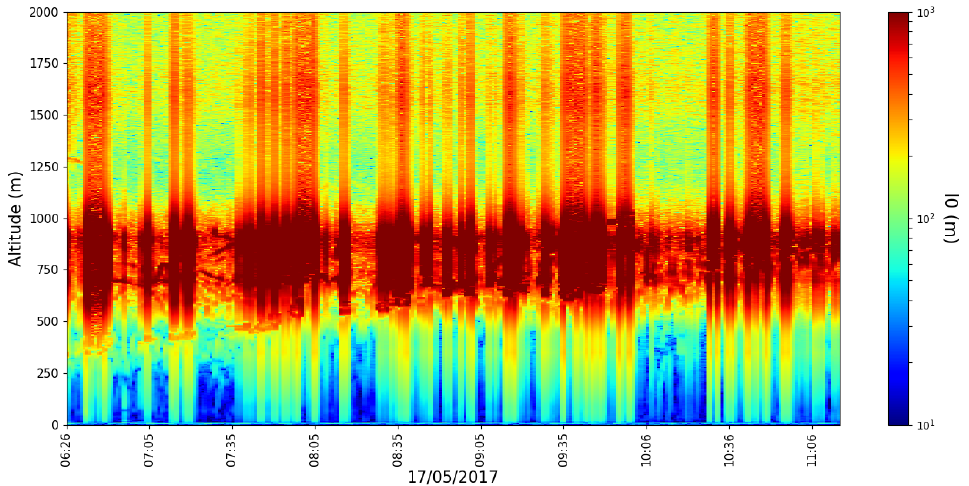
Figure 16. 𝑁 profile timeseries, profiling rate 1/min, 28 April 2017.